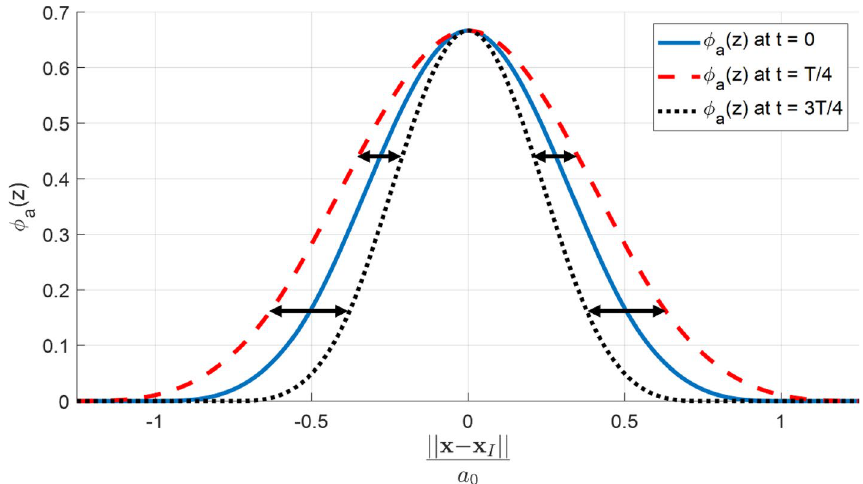
Fig. 7 Change in kernel shape over